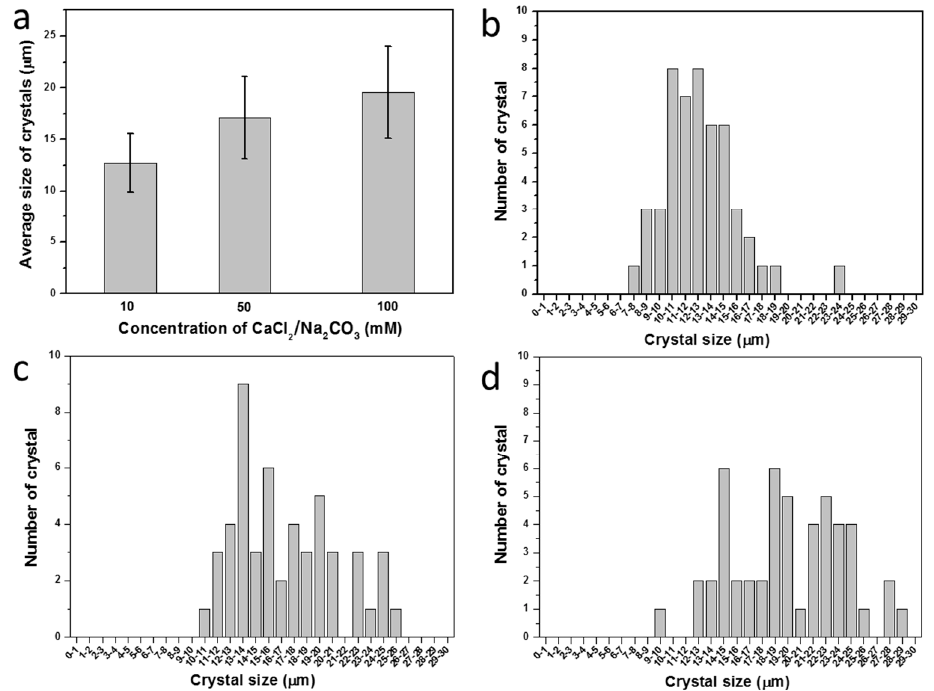
Figure 7. ( a ) Average sizes with standard deviations of CaCO 3 crystals according to concentration of CaCl 2 /Na 2 CO 3 precursor solution. The size distribution of CaCO 3 crystals prepared at different concentrations of CaCl 2 /Na 2 CO 3 precursor: ( b ) 10 mM; ( c ) 50 mM; and ( d ) 100 mM.